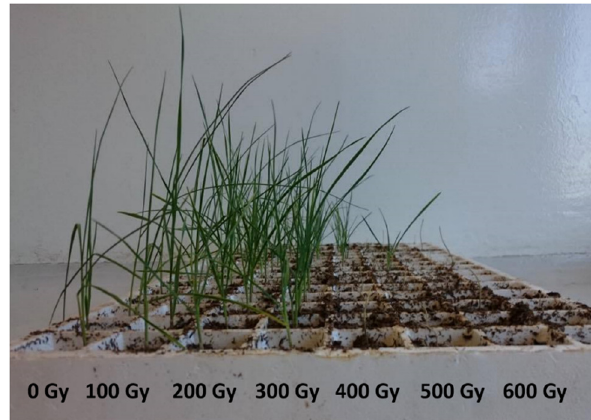
Figure 3: Survival percentage and plant height of irradiated wheat var. CIRNO C2008 seeds, under growth chamber conditions.